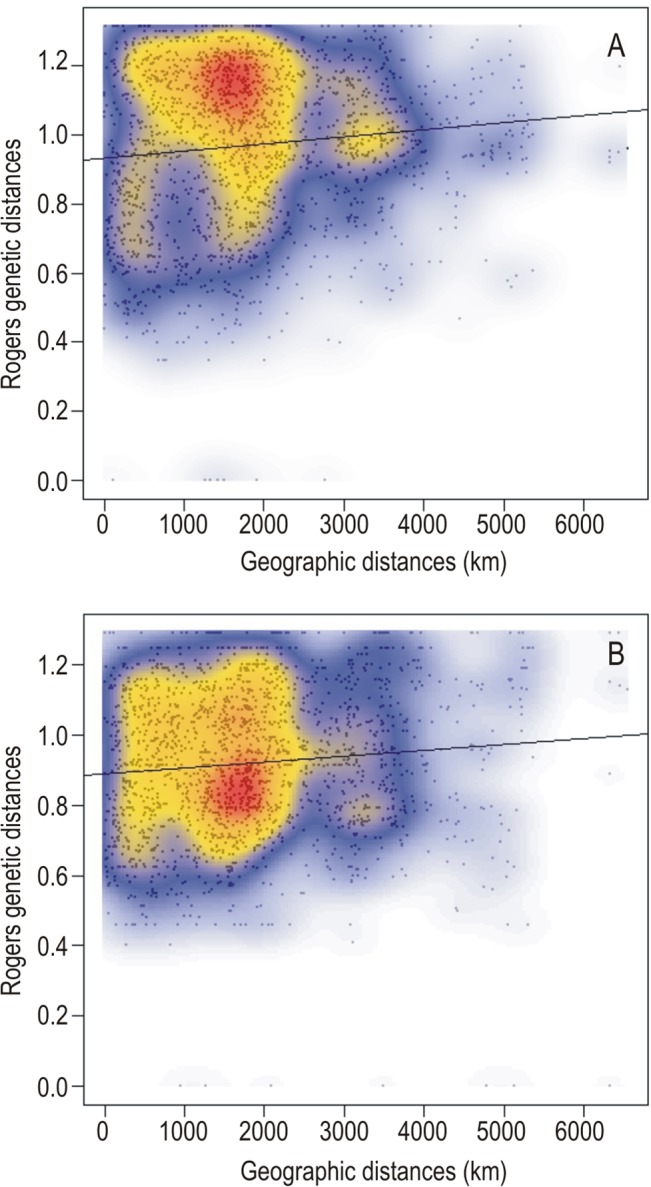
Isolation by distance plot.Scatterplots of local densities of Rogers genetic distances of MLHs against pairwise geographical distances of the sites. A) Including all samples per site, adjusted R2 = 0.01193, p < 0.001; and B) excluding redundant haplotypes per site, adjusted R2 = 0.00945, p < 0.001.